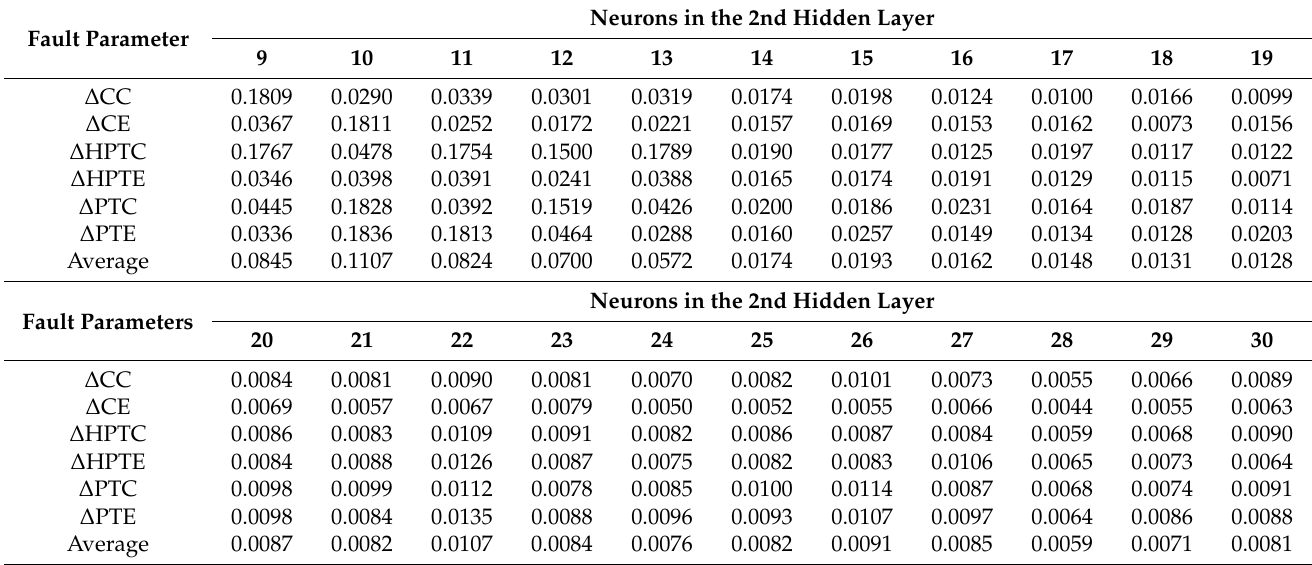
Table 3. Selection of optimal neurons number (turbo shaft, relative spool speed 1.0). Fault